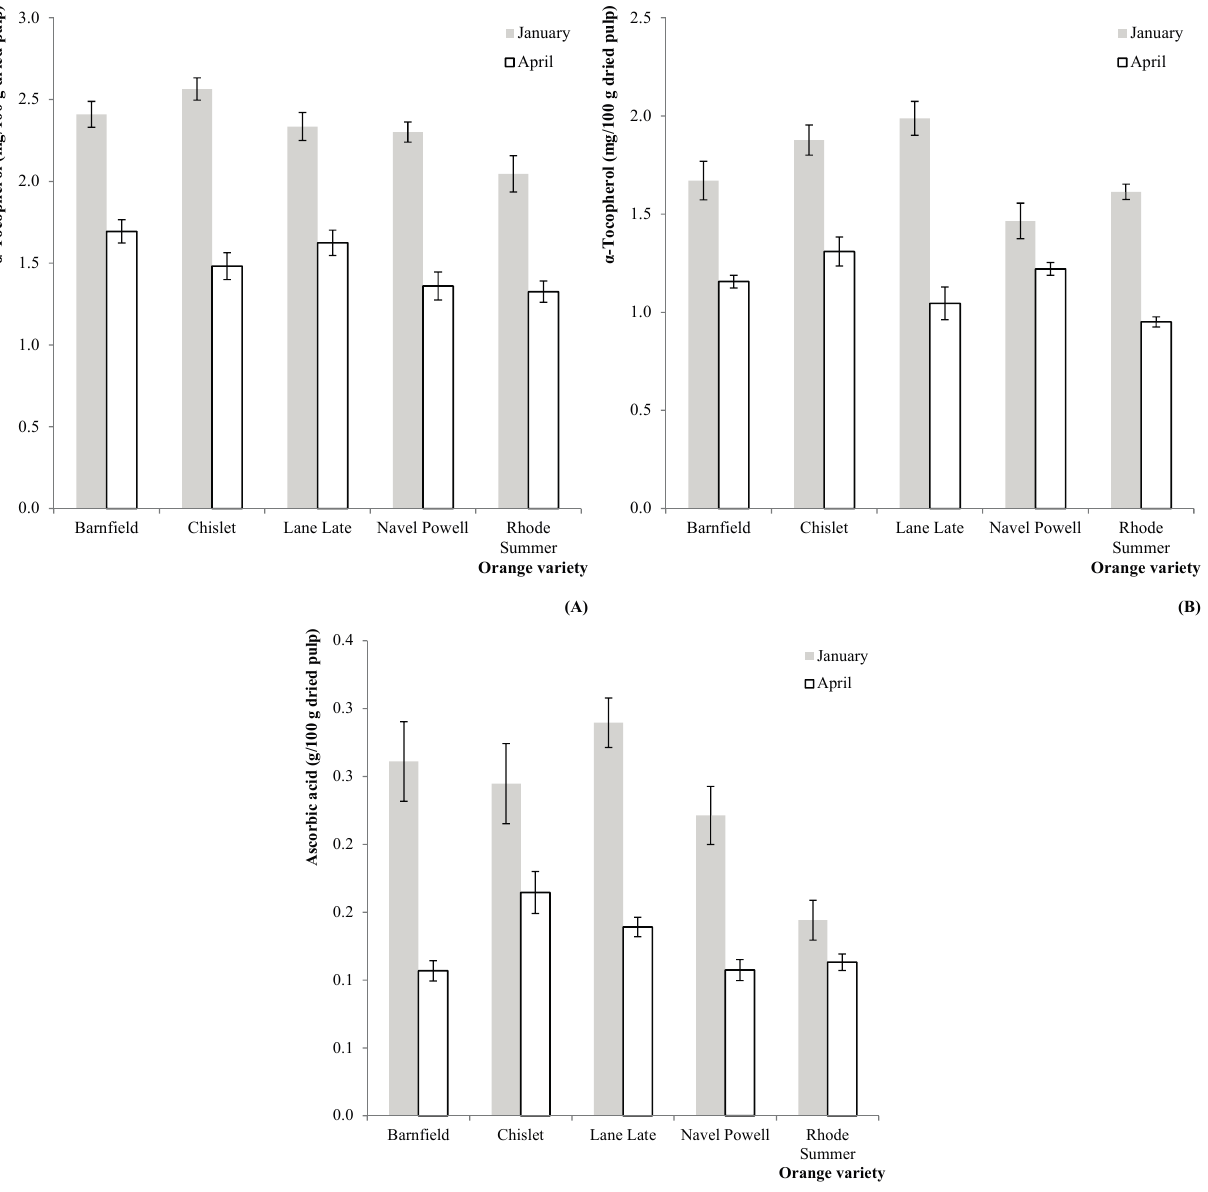
Figure 1. Estimated marginal mean plots representing the effect of harvesting season (HS) on the antioxidant vitamins of C. sinensis fruits. ( A ) α -tocopherol (2011); ( B ) α -tocopherol (2012); ( C ) ascorbic acid